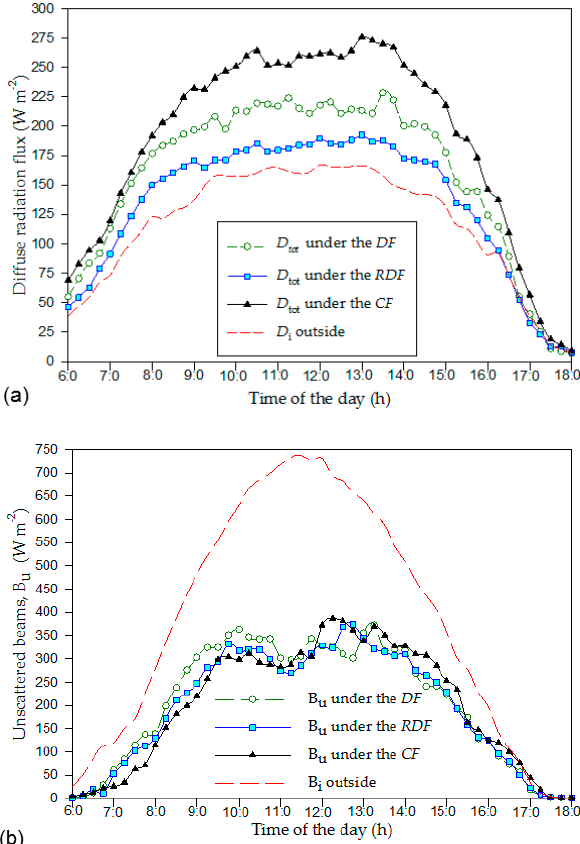
Figure 7. Diurnal variations of ( a ) the incident ( D i ) and transmitted ( D tot ) diffuse radiation fluxes into the three greenhouse models, and ( b ) the unscattered beams radiation incident ( B i ) and transmitted ( B u ) into the three greenhouse models on a sunny day (30 September 2019).